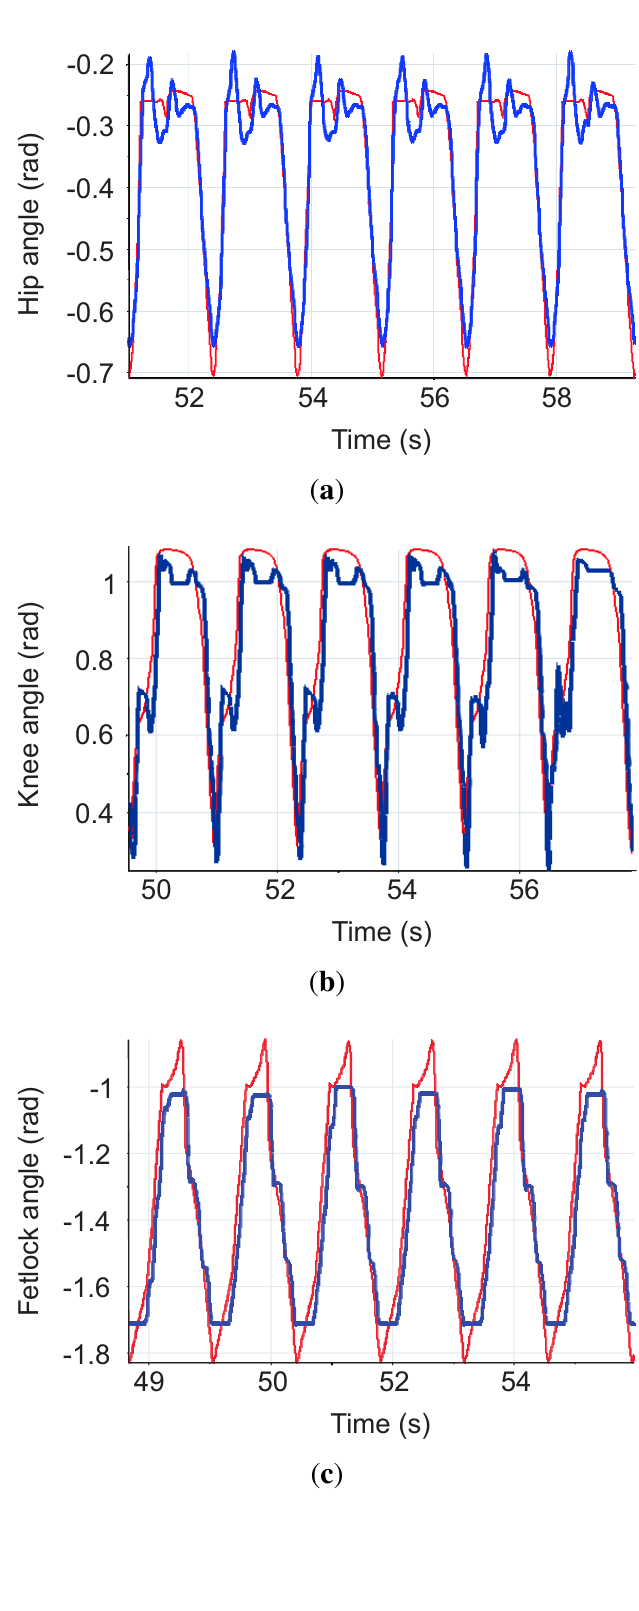
Figure 25. Experimental joint trajectories (thick line) and simulated joint trajectories (thin line) ( a ) hip; ( b ) knee; ( c )